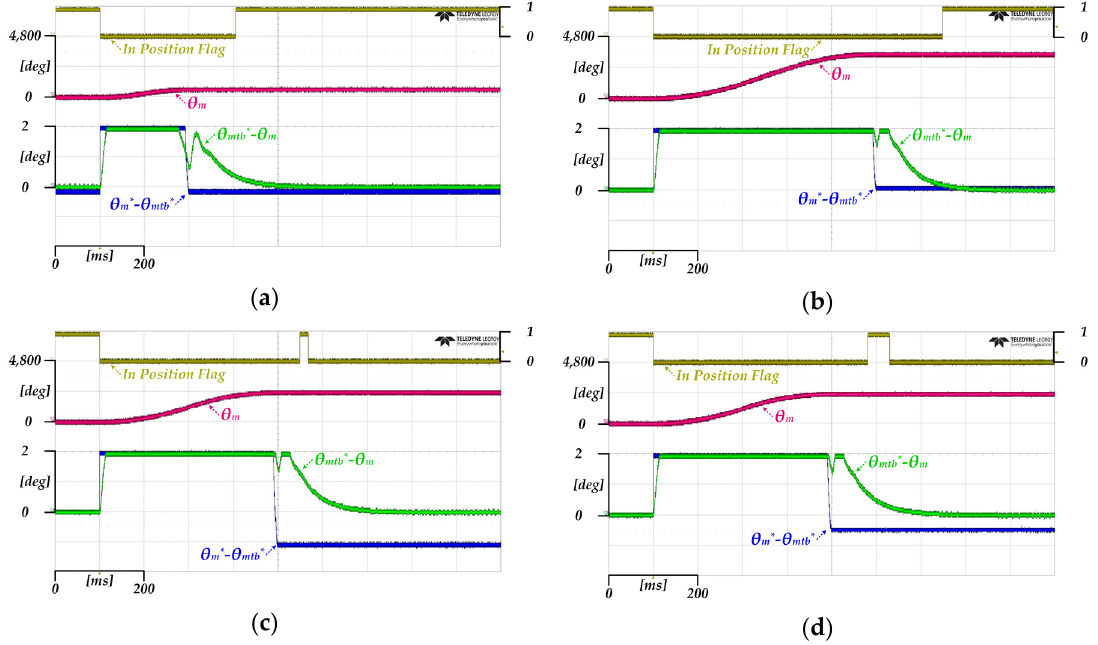
Figure 9. The reference error and position error ( a ) 1200[deg] position reference; ( b ) 3600[deg] position reference; ( c ) 2398.9[deg] position reference; ( d ) 2400.7[deg] position reference.